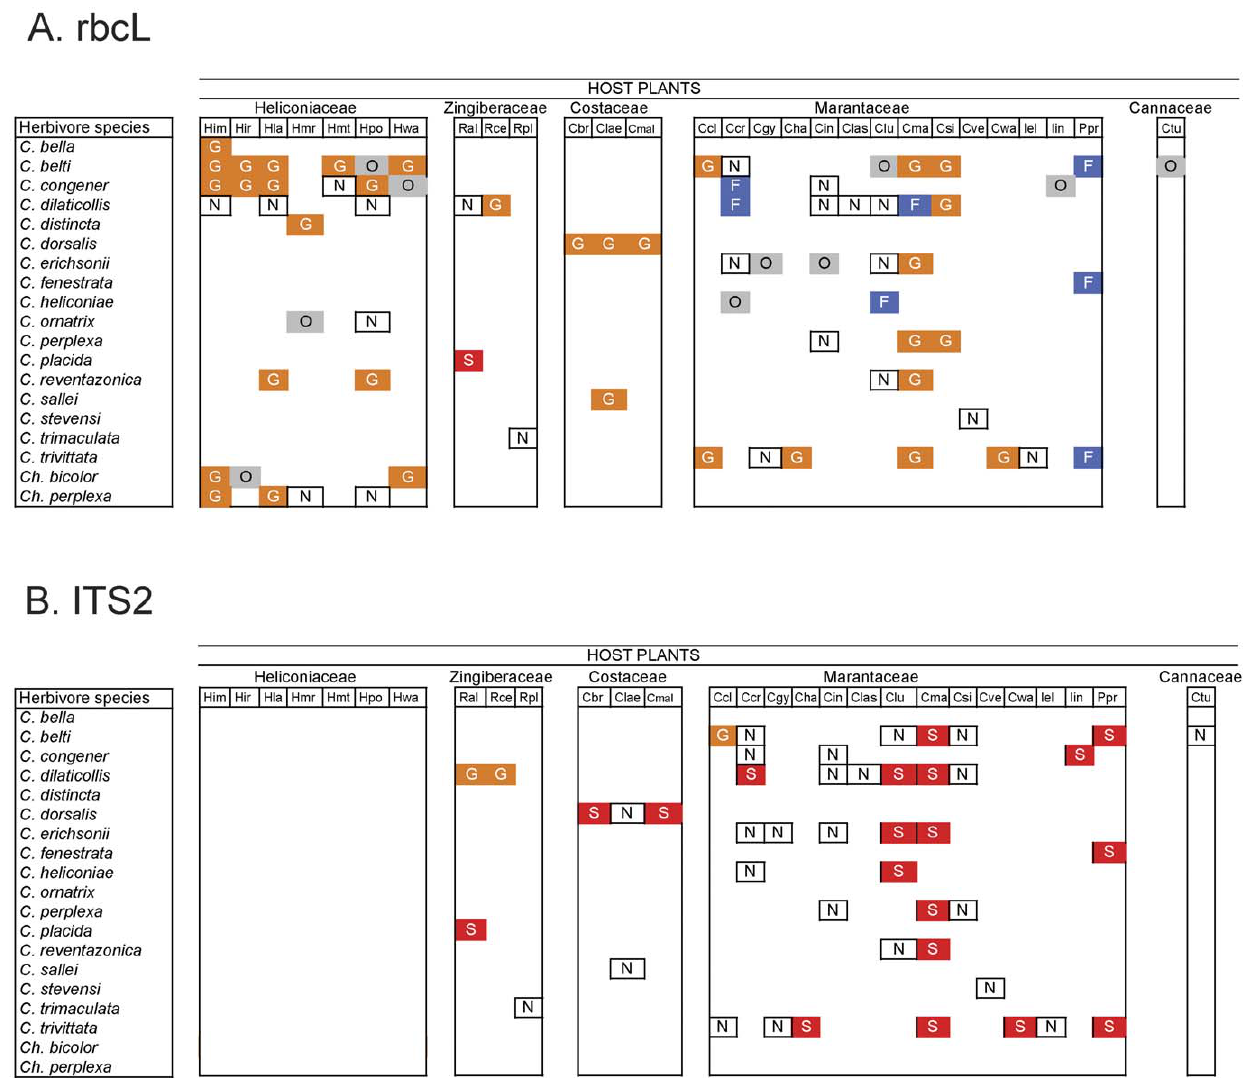
Figure 3. Identification of insect-host plant associations using DNA extracted from rolled-leaf beetle gut contents. Diet identification was performed using the molecular markers: A . rbcL and B . ITS2. Each matrix element represents the associations between a rolled-leaf beetle species (rows) and a host plant (columns). N=interaction failed to be identified by the molecular marker. Taxonomic resolution of successful host plant identifications: O=Order, F=Family, G=Genus, S=Species. Total of sequences=403 (DNA sequences extracted from insect gut contents are included in Supplement S1). Plant species abbreviations as in Figure 2.